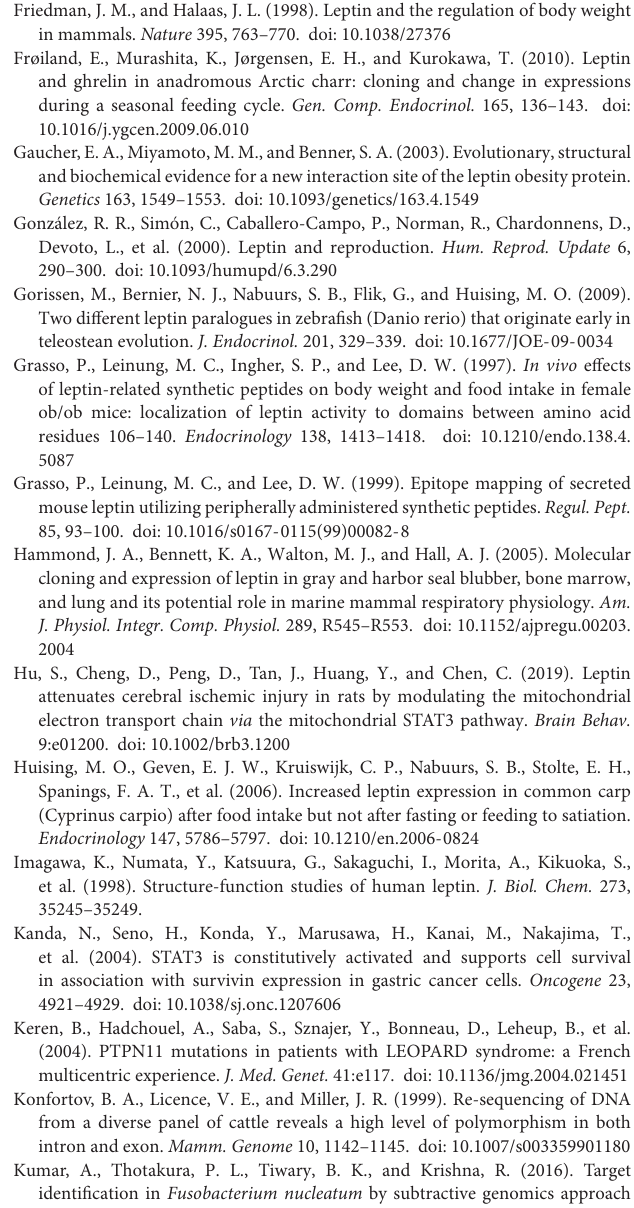
Supplementary Table 1 | Primers for genes involved in signal transduction